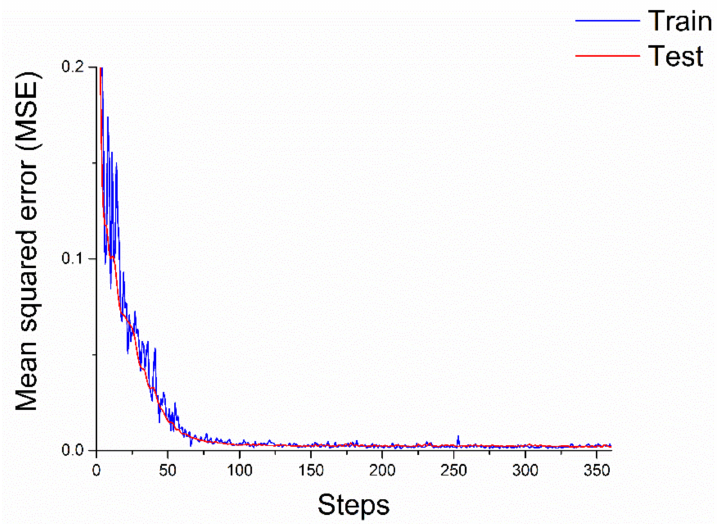
Figure 7. The training and test in process.